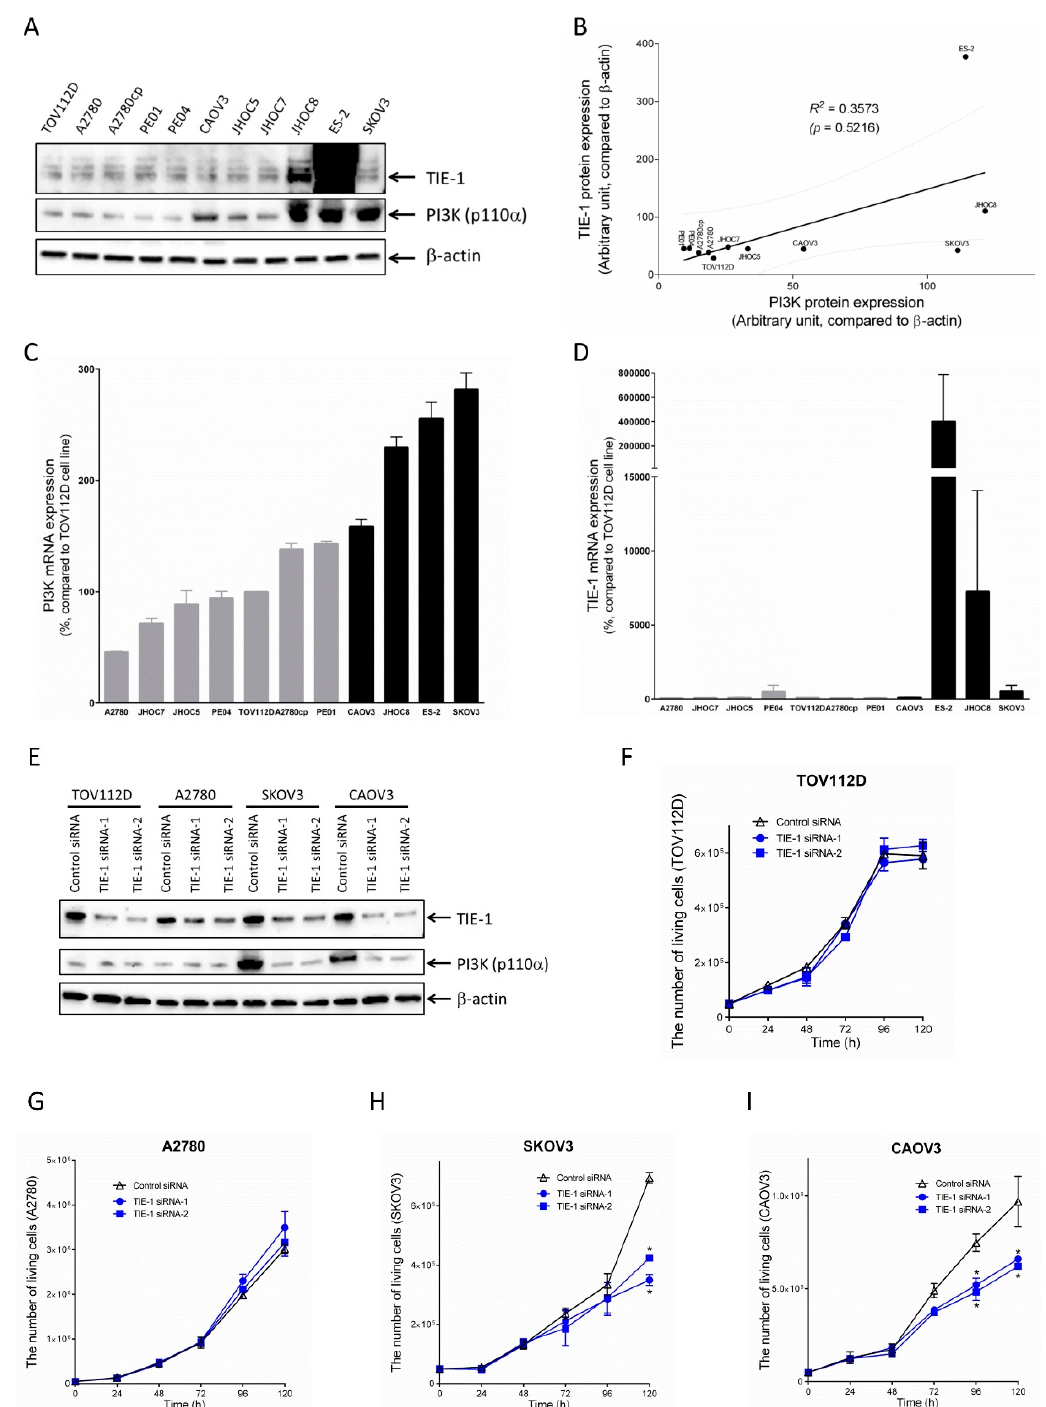
Figure 2. Inhibition of TIE-1 decreases cell growth in high-PI3K-expressing cell lines. ( A ) Extracted cellular proteins from indicated ovarian-cancer cell lines were subjected to immunoblot analysis with antibodies against TIE-1, PI3K p110 α , and β -actin. Equal amounts of protein were loaded in each lane. Three independent experiments were performed, and representative images are shown. Intensity of TIE-1 and PI3K p110 α protein expression quantified using Image Lab. ( B ) TIE-1 protein expression plotted with PI3K p110 α protein expression, and R 2 values determined by GraphPad prism. mRNA expression levels of ( C ) PI3K p110 α and ( D ) TIE-1 in eleven ovarian-cancer cell lines confirmed by quantitative real-time PCR. ( E ) TOV112D, A2780, SKOV3, and CAOV3 ovarian-cancer cells